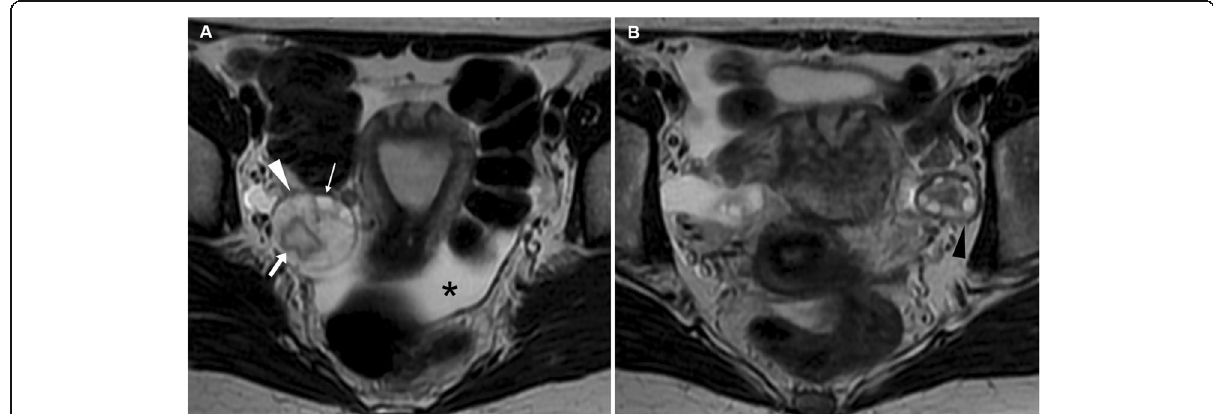
Fig. 20 Unilateral massive ovarian oedema in a 23-year-old woman with recurrent self-limiting episodes of acute pelvic pain in the last year. Oblique coronal T2-weighted image ( a ) shows enlargement (4 cm diameter) of the right ovary (arrowhead) characterised by oedematous hyperintense stroma; follicles (thin arrow) and corpus luteum (arrow) are displaced at the periphery of the cortex. Moderate peritoneal effusion (asterisk) coexists. Oblique coronal T2-weighted image ( b ) demonstrates the normal-appearing left ovary (black